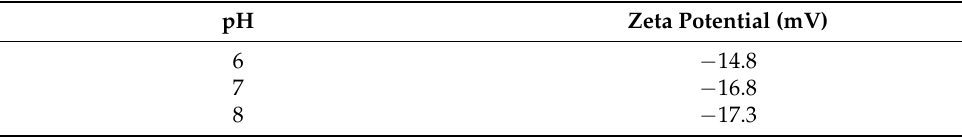
Table 1. Effect of pH on the zeta potentials of